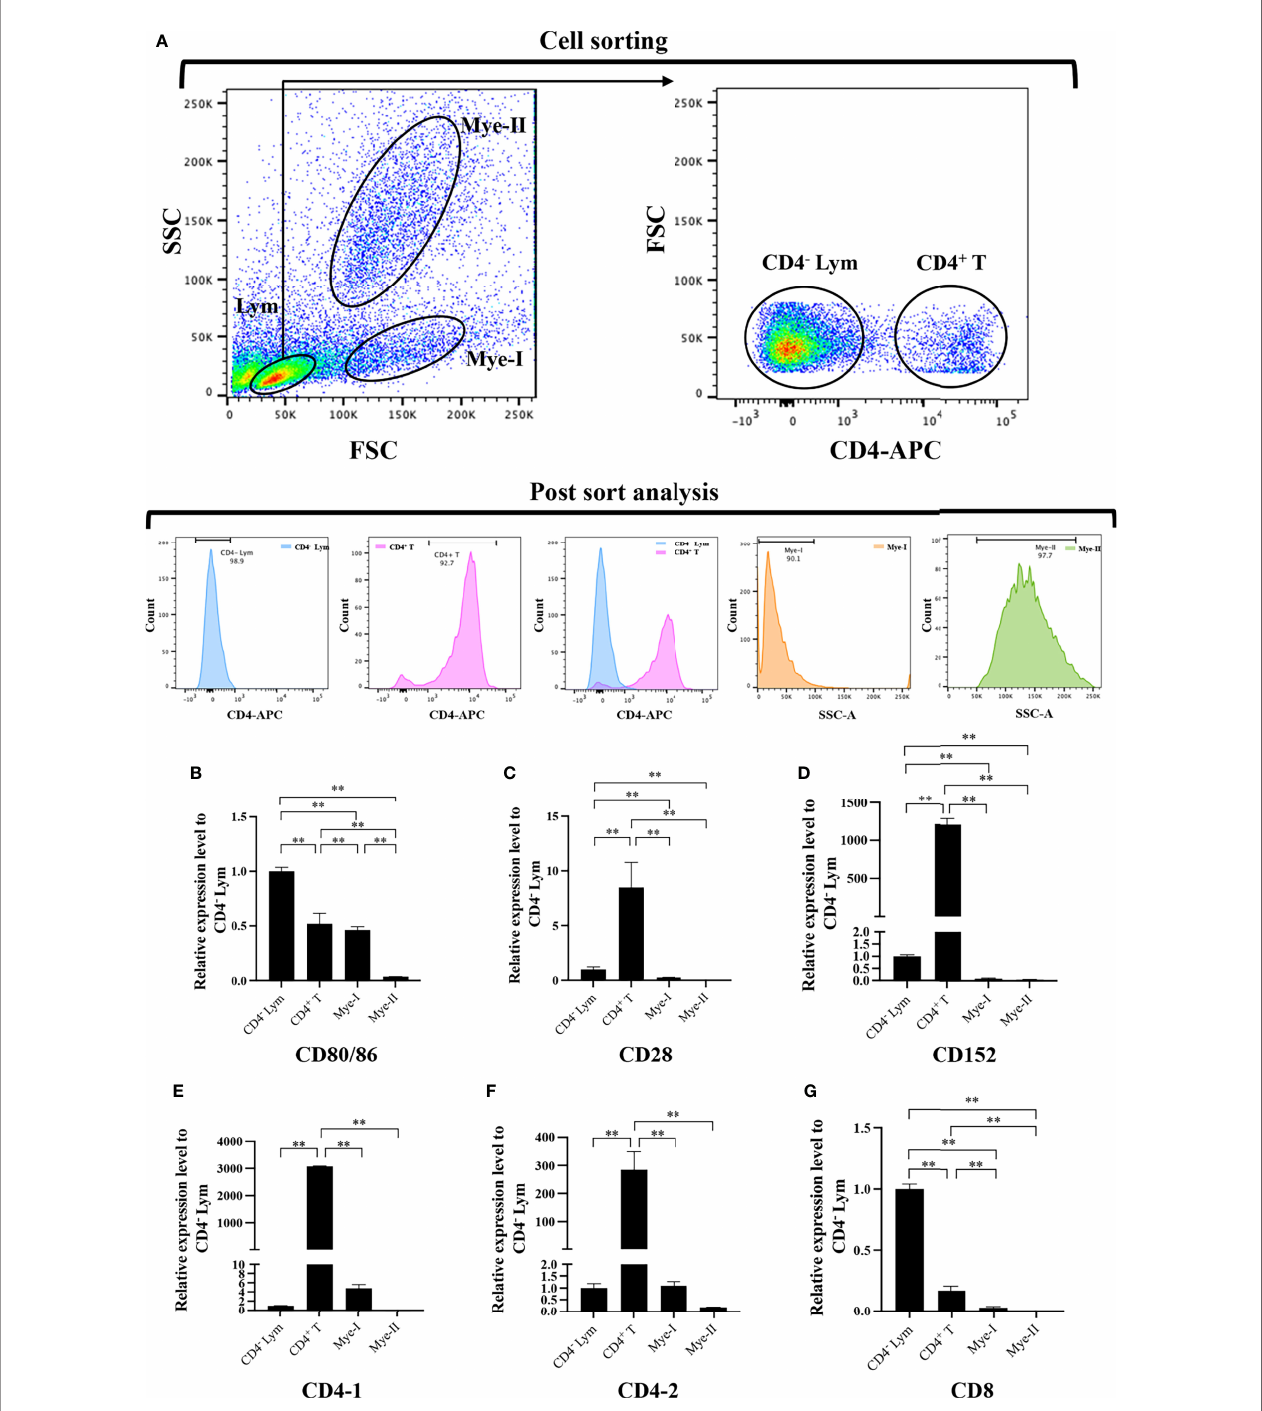
FIGURE 6 | Expression patterns of the grass carp CD80/86, CD28 , CD152 , CD4-1 , CD4-2 , and CD8 genes in head kidney leukocyte populations stained with rat anti-carp CD4 mAbs. (A) Flow cytometry analysis of the HKLs stained with rat anti-carp CD4 mAbs and APC-goat anti-rat IgG Abs. Four different cell populations were sorted: CD4 + T cells, CD4 - lymphocytes (Lym), myeloid I subset cells (Mye I), and myeloid II subset cells (Mye II). The purity of the sorted cells was analyzed by FACS. (B – G) The mRNA expression levels of CD80/86 (B) , CD28 (C) , CD152 (D), CD4-1 (E), CD4-2 (F) , and CD8 (G) genes in the four different cell populations were detected using qPCR. One representative result is represented by the fl ow cytometry dot plot. The mRNA expression levels were analyzed by qPCR and normalized against b -actin using the 2 − D Ct method. The p value was calculated using ANOVA with the LSD post hoc test (** p < 0.01). Data are presented as mean ± SEM (n = 3 fi